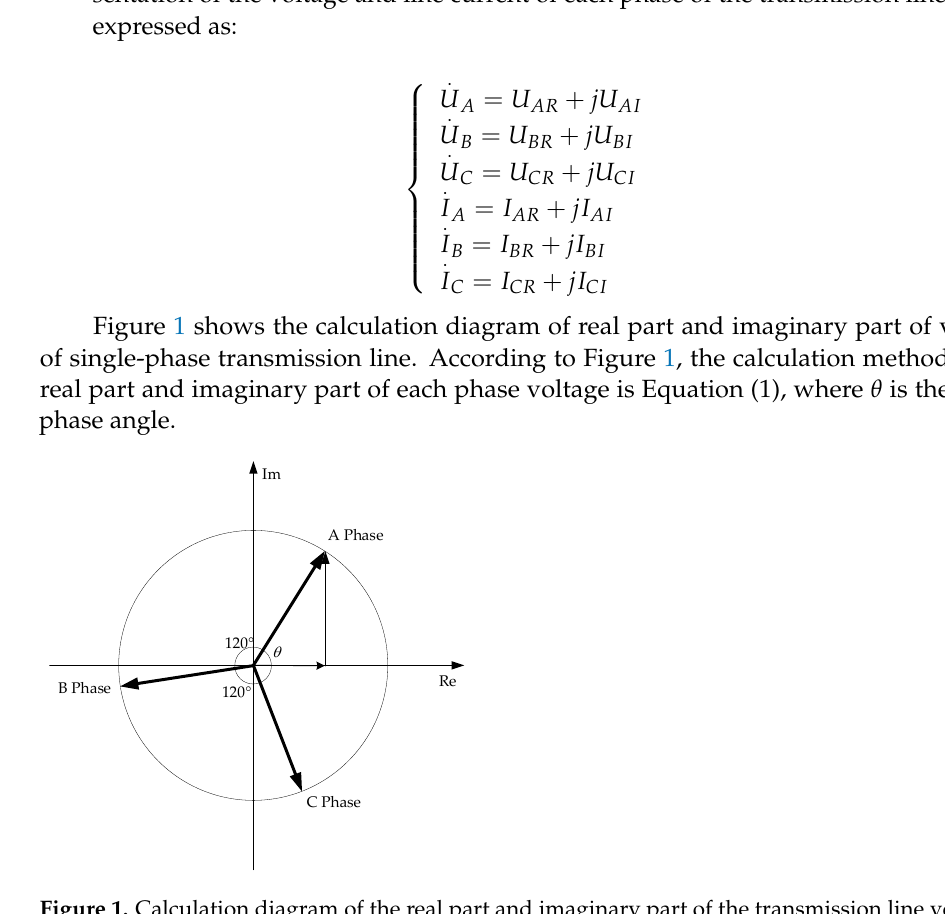
Figure 1. Calculation diagram of the real part and imaginary part of the transmission line voltage.